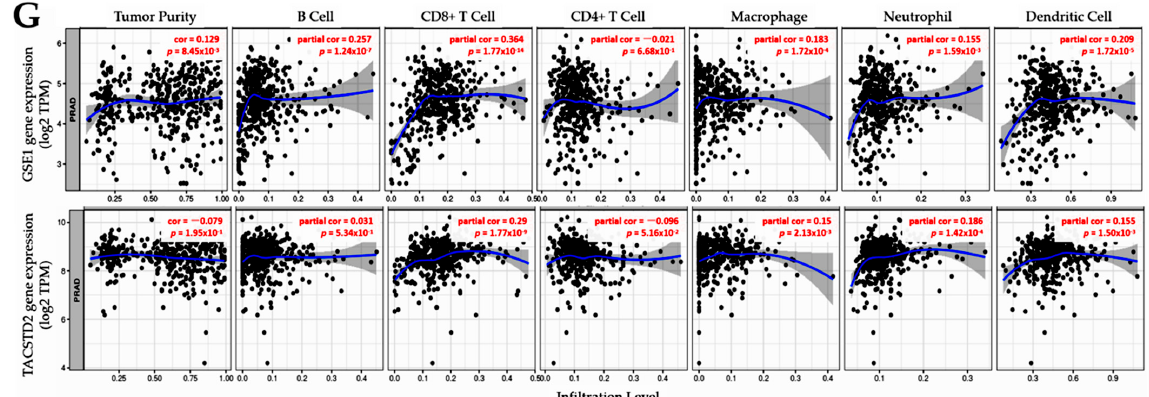
Figure 4. The GSE1 and TACSTD2 signal interplay affects the clinical and immune statuses of patients with prostate cancer. Box-and-whisker plots showing the relationship between ( A ) GSE1 or ( B ) TACSTD2 expression and copy-number-based iClusters in the MSKCC dataset. Box-and-whisker plots of the relationship between ( C ) GSE1 or ( D ) TACSTD2 expression and Gleason score in the MSKCC dataset. Kaplan–Meier curves showing the effect of the differential expression of ( E ) GSE1 or ( F ) TACSTD2 on biochemical recurrence-free survival. ( G ) Scatter-plot visualization of the tumor purity-adjusted correlation between GSE1 or TACSTD2 expression and immune cell infiltration levels in PRAD. The abundance of six immune infiltrates, namely, B cells, CD4+ T cells, CD8+ T cells, neutrophils, macrophages, and dendritic cells, were estimated using the TIMER algorithm. The gene expression levels against tumor purity are displayed in the left-most panel. Genes highly expressed in the microenvironment are expected to have negative associations with tumor purity, while the opposite is expected for genes highly expressed in the tumor cells.